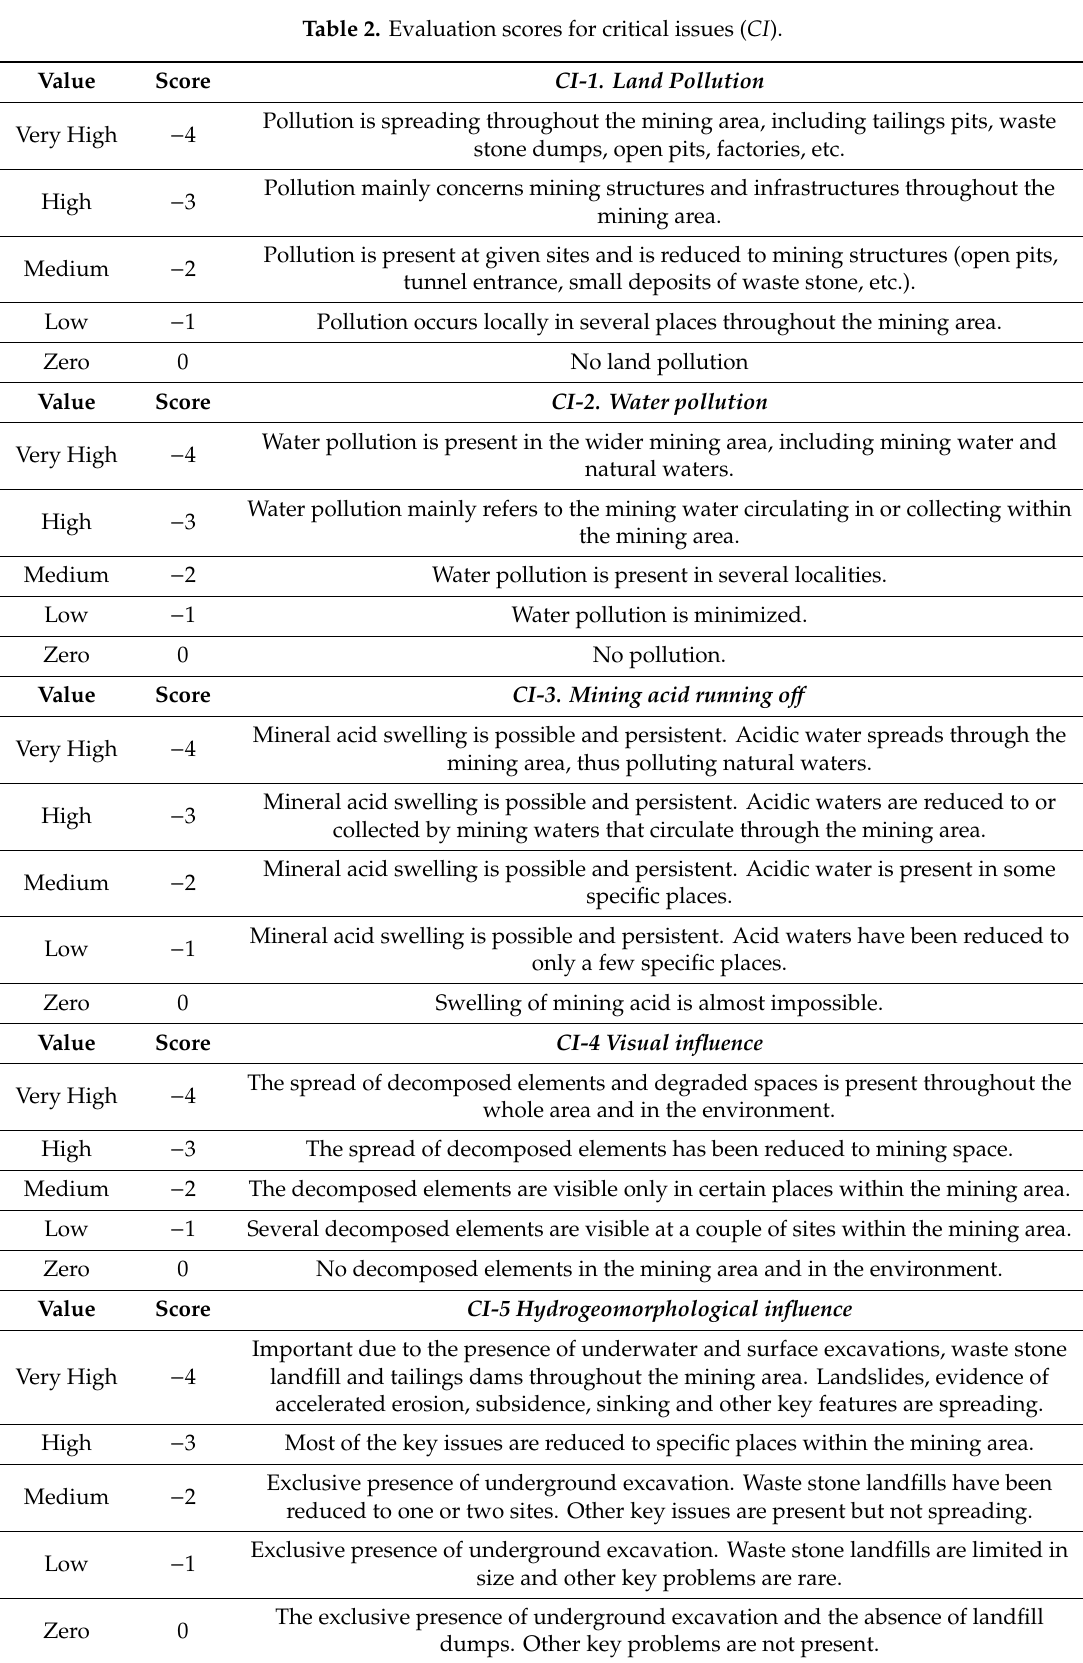
Table 2. Evaluation scores for critical issues ( CI